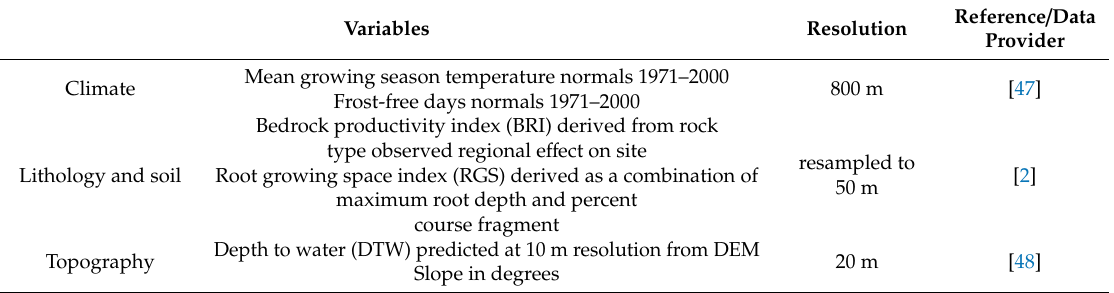
Table 2. Site variables used in the